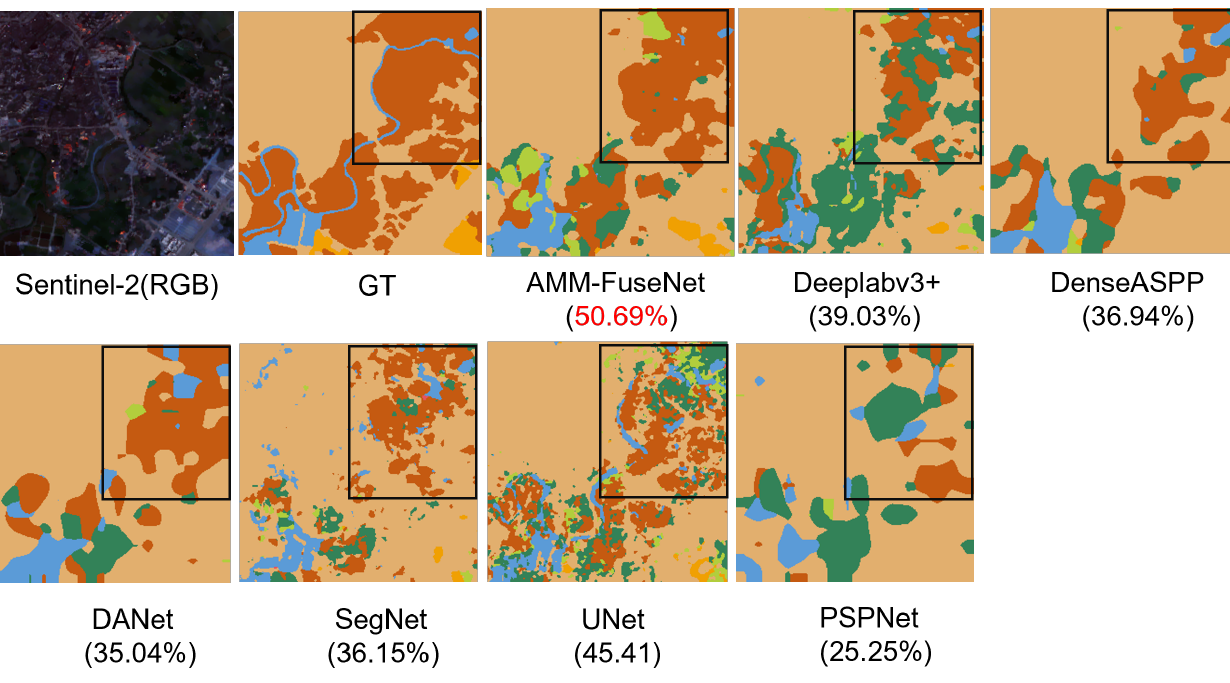
Figure 8. Results on the Hunan dataset (Sentinel-2 and DEM) values between parentheses refer to mIoU in percentages for the example image for each model, where the best model is shown in